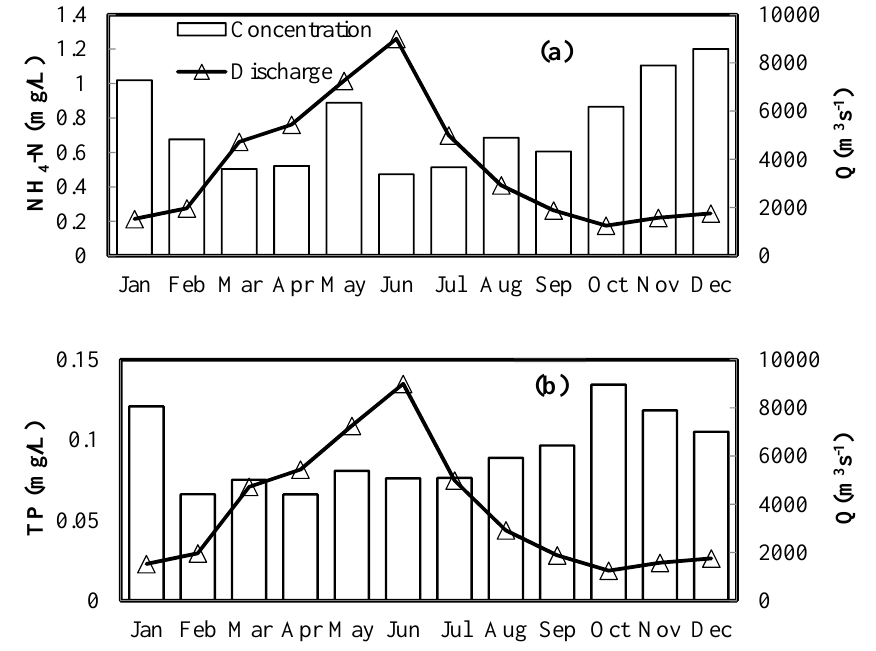
Figure 9. Monthly ( a ) TP and ( b ) NH 4 –N concentrations and discharge from the tributaries of Poyang Lake (2009–2011).